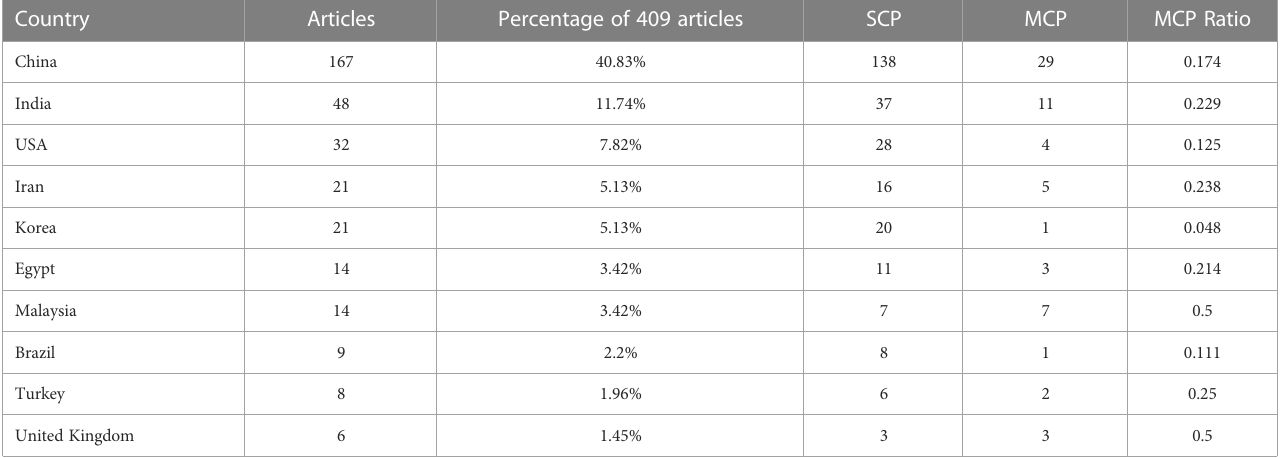
TABLE 1 Total number of publications, single country publications, and multiple country publications of top 20 Countries by corresponding authors. Country